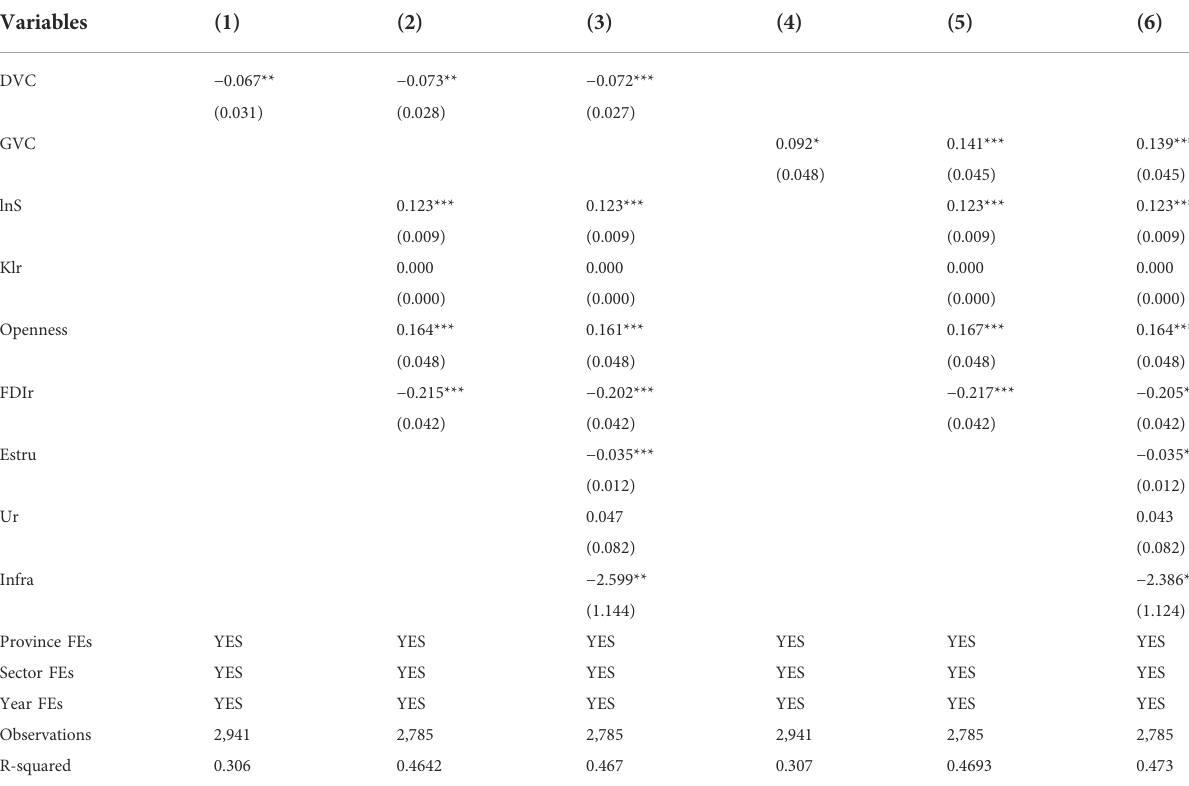
TABLE 3 Regression results of dual value chain embedding and productivity.